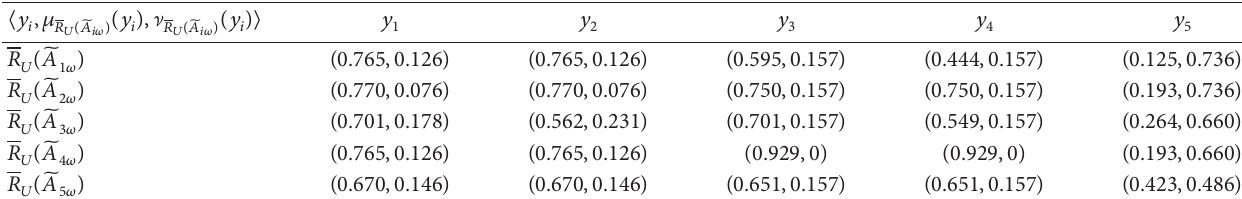
Table 5: The upper approximations of weighted Atanassov’s intuitionistic fuzzy